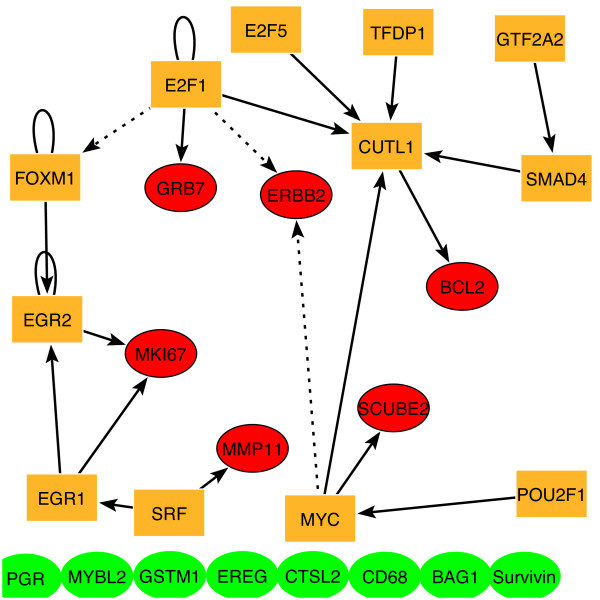
Breast cancer condition specific (CS) regulatory sub-network. We studied the Dutch datasets [39, 44, 55] to identify regulatory connections between sixteen genes that were recently implicated in recurrence in node-negative breast cancer [56]. To visualize regulatory distances between these genes and to identify the regulators involved in their co-alteration in the CS recurrence regulatory network, we extracted from this CS network a sub-network involving these genes and all the TFs that regulate them directly or indirectly. Fourteen of these genes are included in the Dutch datasets (red and green ovals). Six of the genes (red) form a highly connected and localized CS sub-network. TFs linked to any of these genes directly or indirectly are denoted by yellow boxes. Solid arrows stemming from Myc and E2F1 represent links supported by ChlP-on-chip experiments [29], whereas predicted links that were not matched by these non-breast cancer experimental data are shown with dotted arrows.